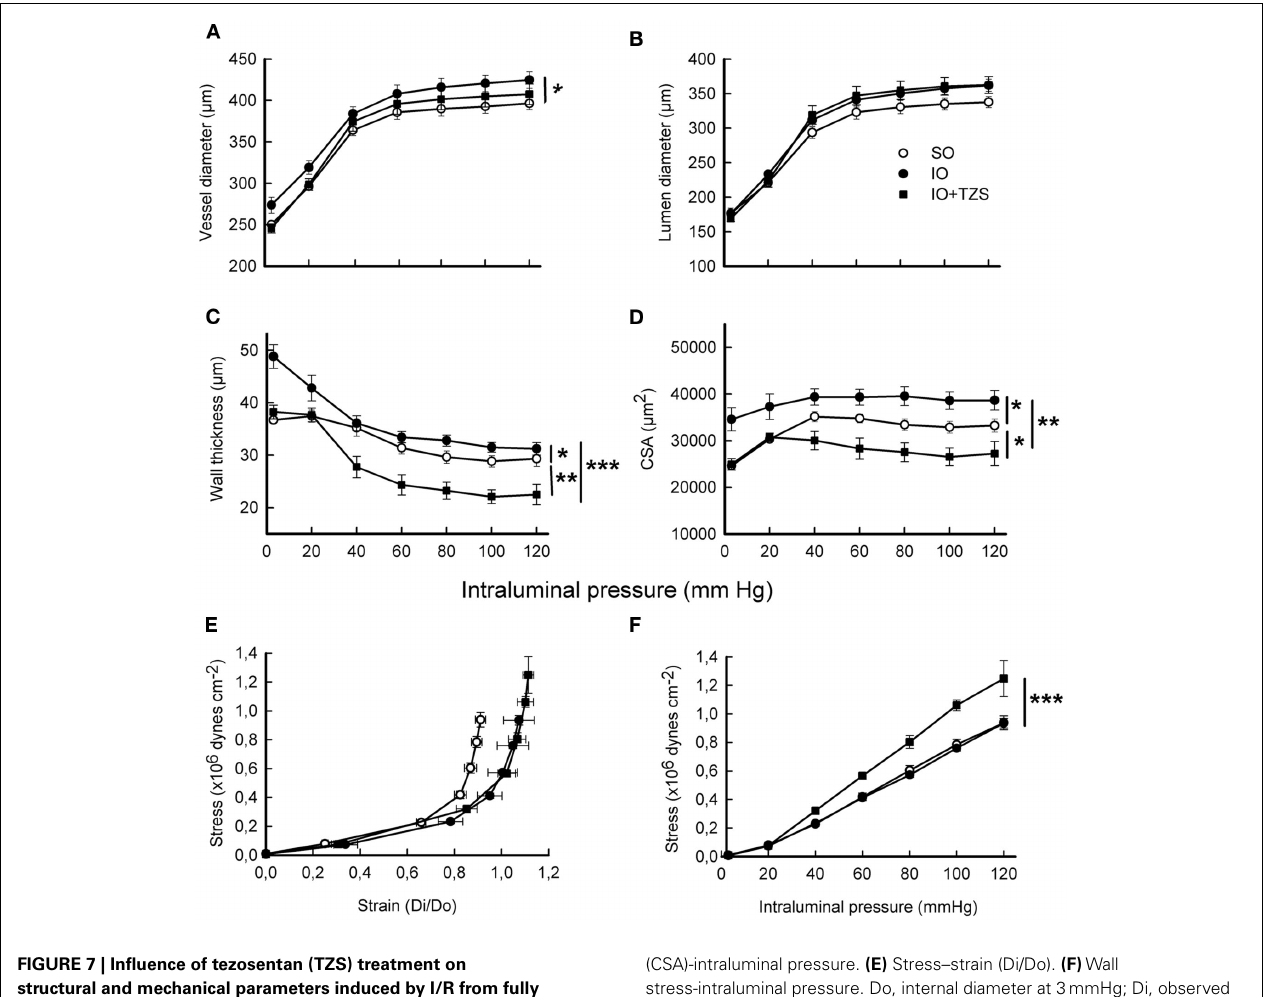
FIGURE 7 | Influence of tezosentan (TZS) treatment on structural and mechanical parameters induced by I/R from fully relaxed mesenteric resistance arteries. (A) Vessel diameter-intraluminal pressure. (B) Lumen diameter-intraluminal pressure. (C) Wall thickness-intraluminal pressure. (D) Cross-sectional area